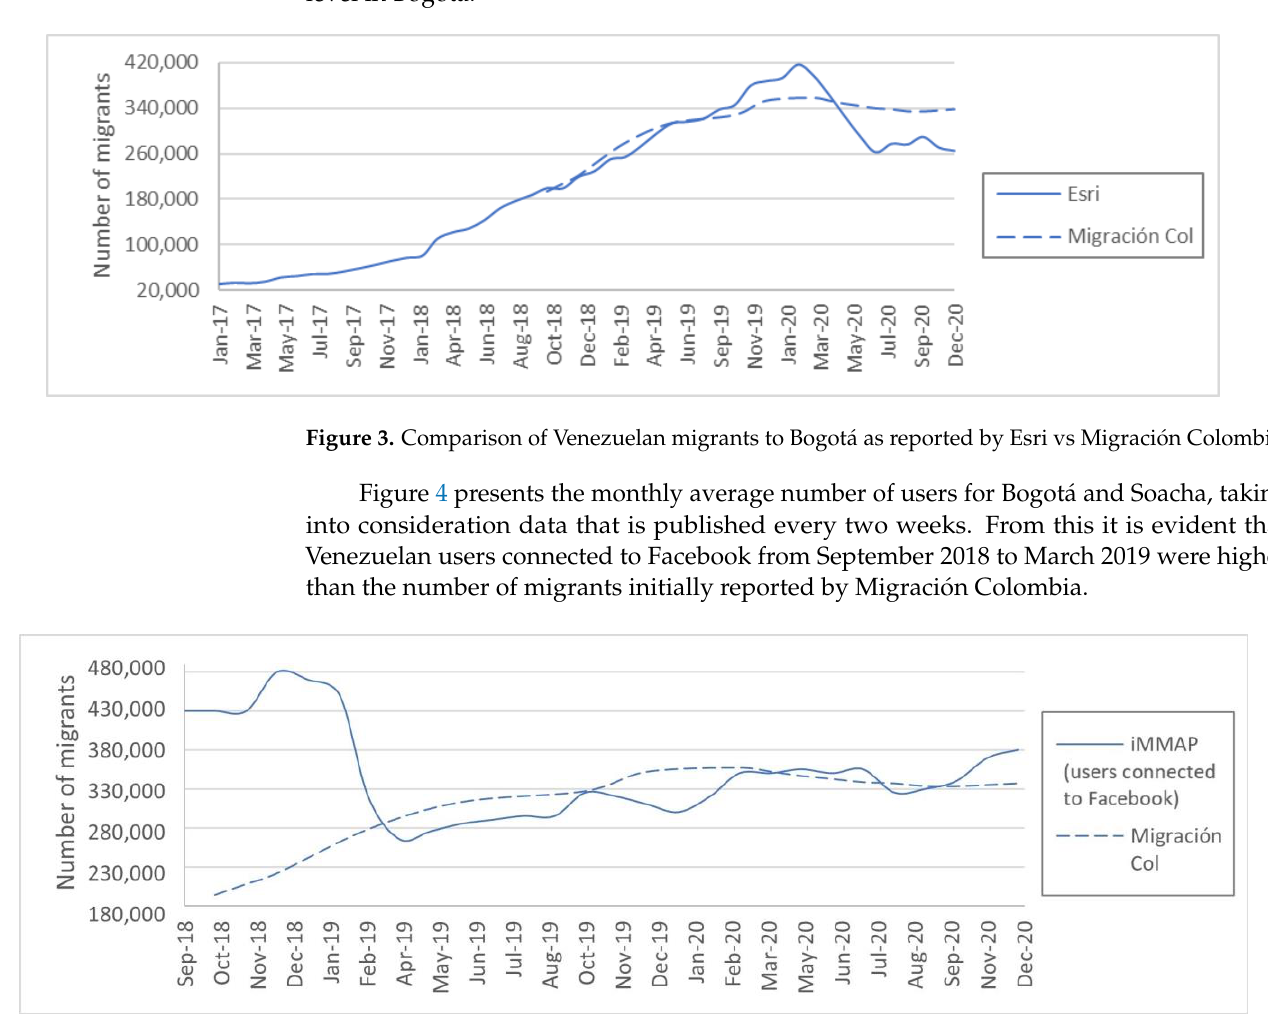
Figure 3. Comparison of Venezuelan migrants to Bogotá as reported by Esri vs Migración Colombia.